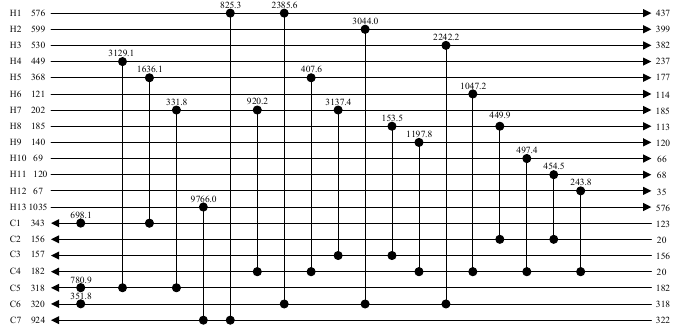
Figure 13. RWCE optimization results using the weighted evolution strategy.